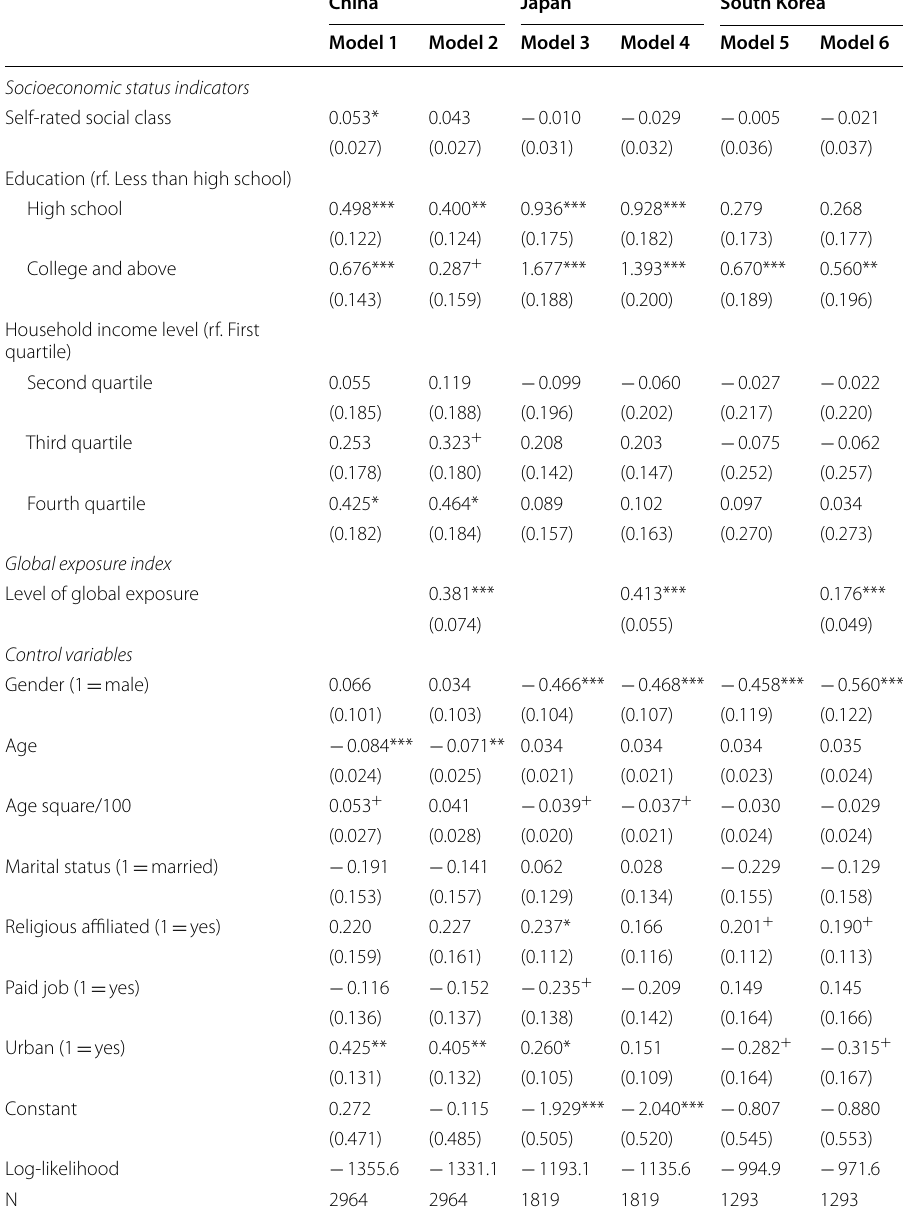
Table 3 Logit regression models on vertical cultural